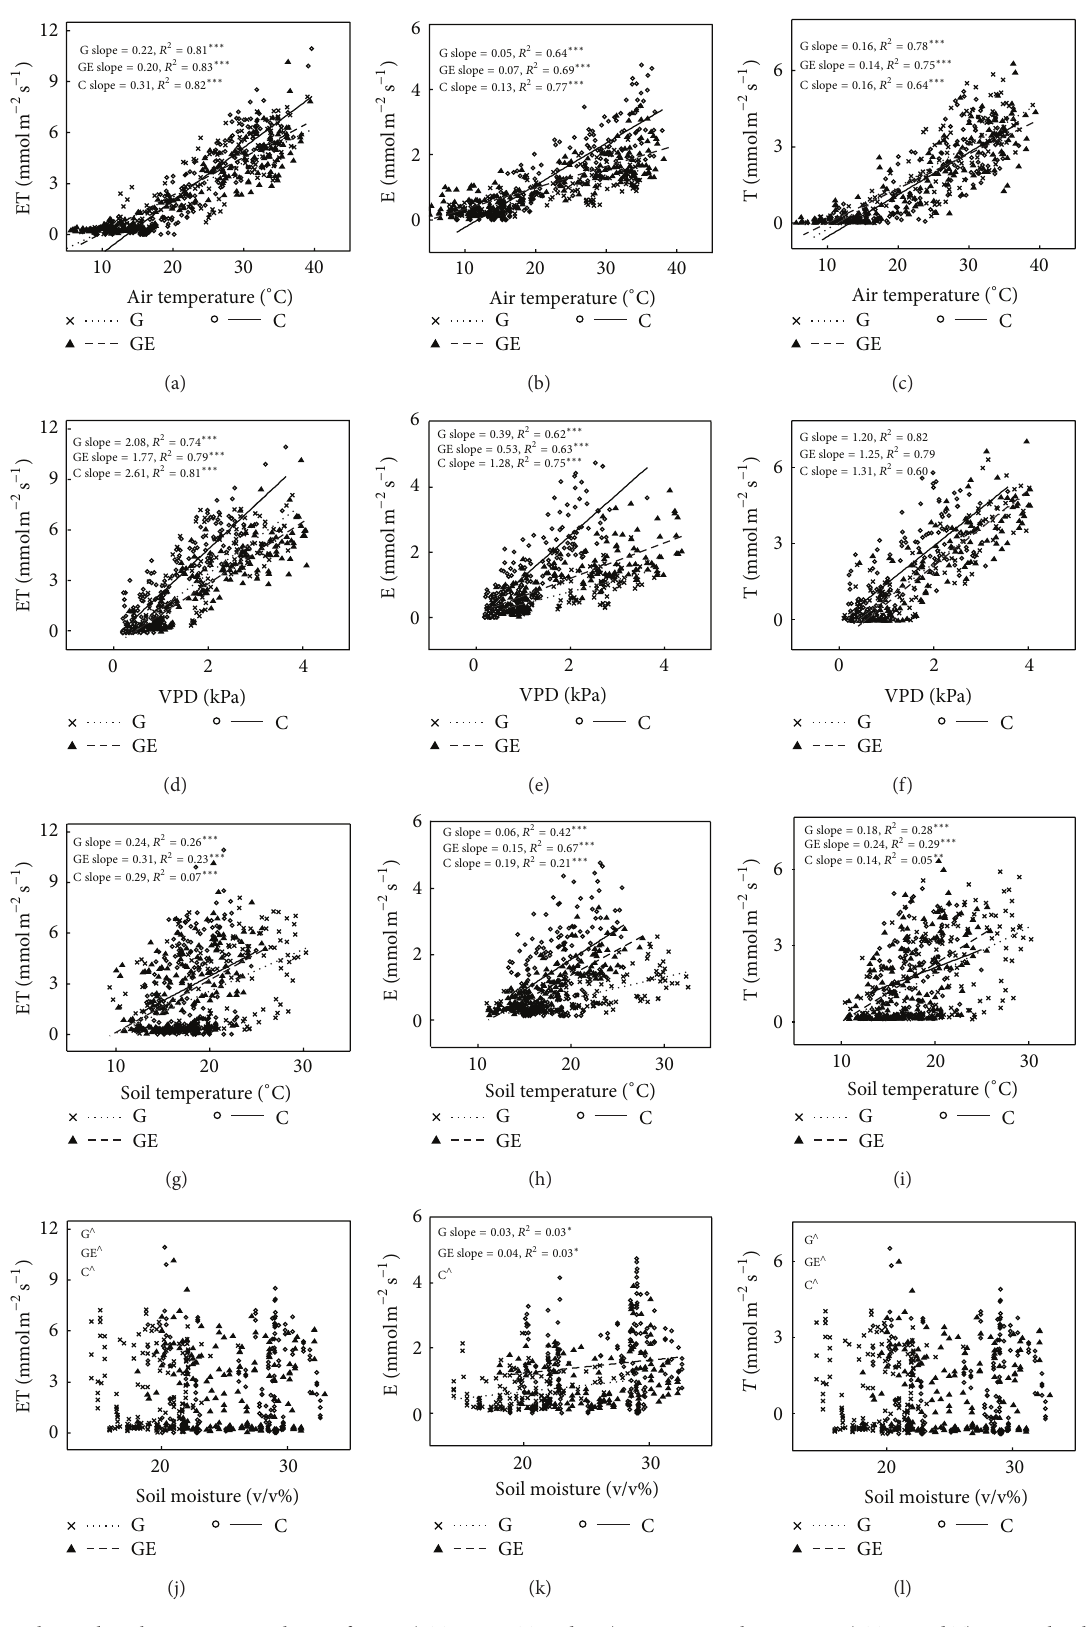
Figure 5: Relationships between microclimate factors (AT, VPD, ST, and SM) on vapor exchange rates (ET, E, and T) across the three land uses of steppe. R 2 and probabilities of regressions are shown; ∧ 𝑃 > 0.05 ; ∗ 𝑃 < 0.05 ; ∗∗ 𝑃 < 0.01 ; ∗∗∗ 𝑃 < 0.001 . G, grazing; GE, grazing excluded; C,